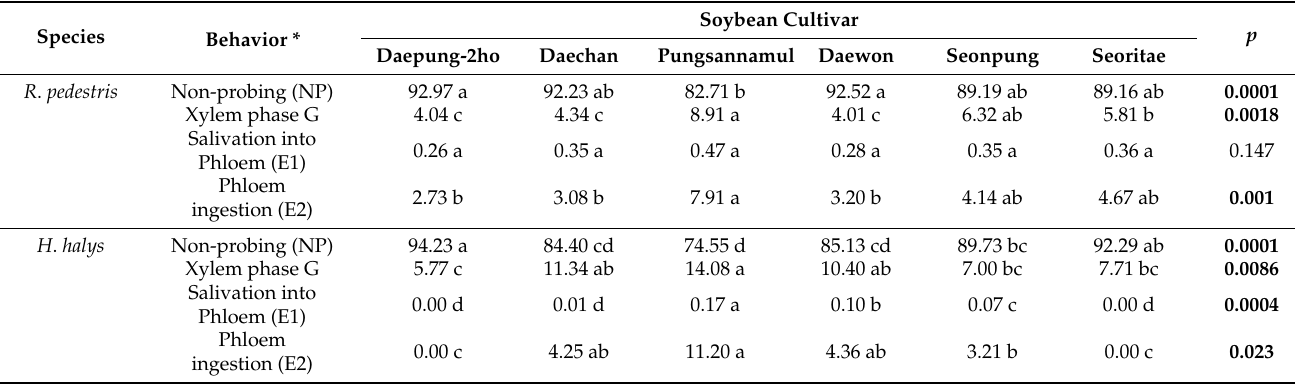
Table 3. Total duration of each waveform event (NP, G, E1, and E2) as proportions of the time spent during the 6 hours of EPG recording of R. pedestris and H. halys . Highlighted in bold are those variables that showed striking significant differences between soybean